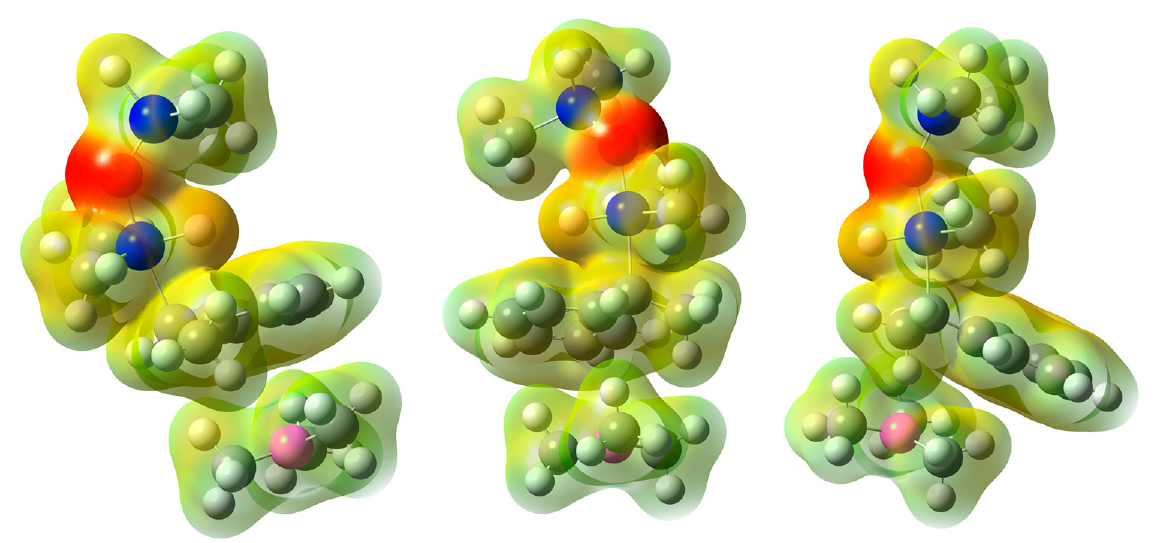
Figure 2. Electron density (mapped by electrostatic potential at 0.01 e - ꞏ a 0 − 3 isovalue) for VIIa , VIIb, and VIIc structures (left to right) in the reaction with TMDSO (blue for silicon, magenta for boron, red for oxygen). BMe 3 was used for computations in place of BEt 3 . Note how the silicon-bonded hydrogen atom is sterically hindered in the lowest-energy a and b conformers.